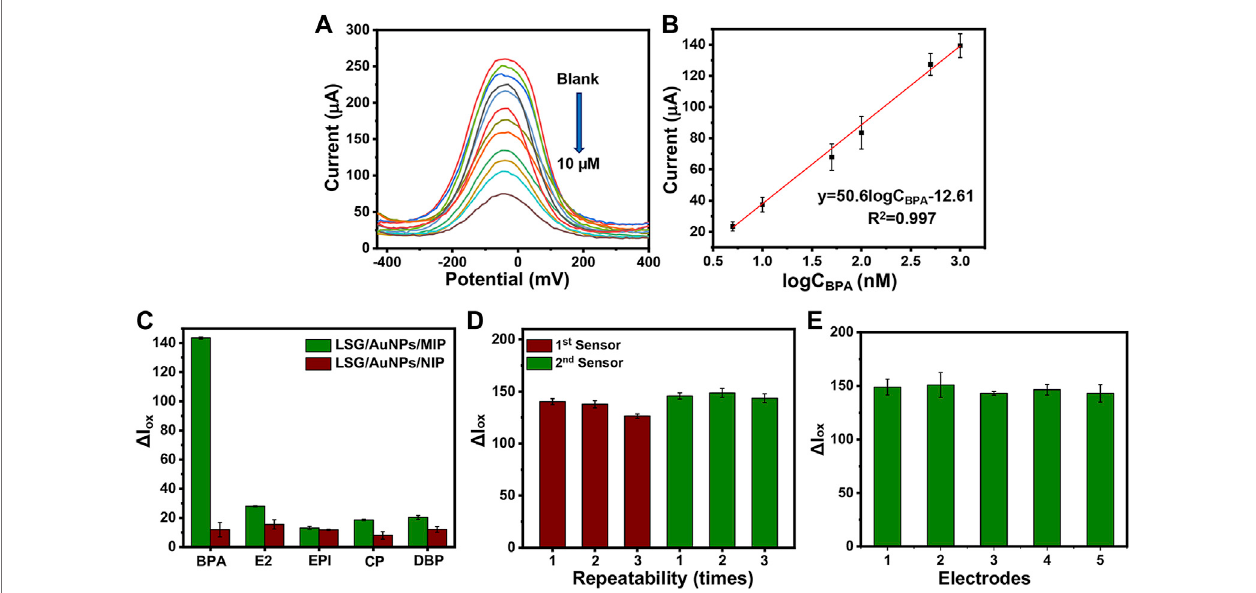
FIGURE6|(A) DPVsobtainedatLSG-MIPincubatedindifferentconcentrationsofBPA. (B) ThecorrespondingcalibrationplotobtainedforLSG-MIP.Histograms obtained fromIox valuesof (C) LSG-MIP and LSG-NIP in thepresence ofBPA, epinephrine (EPI), β -estradiol(E2),4-chlorophenol(CP),and dibutylphthalate (DBP). The concentration of BPA and other inferences used was 1 μ M, (D) LSG-MIP showing the reusability of two different sensors performing removal and rebinding three times consecutively. (E) Reproducibility test showing the response of fi ve different LSG-MIP sensors prepared with the same procedure. The measurements were done byusingoptimalconditions(1 mMBPA,.5 MEDOT,15 minofremovaltime,and20 minofincubationtimeof1 μ MofBPA).KCl(0.1 M)containing5 mM[Fe(CN) 6 ] 3 − /4 − was used as the redox